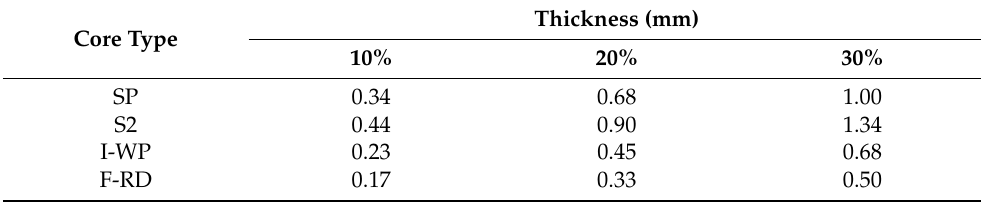
Figure 4. Patterns used to generate SPSs with different TPMS lattice cores: ( a ) SP, ( b ) S2, ( c ) I-WP and ( d ) F-RD. Table 3. Wall thicknesses of TPMS lattices at different relative